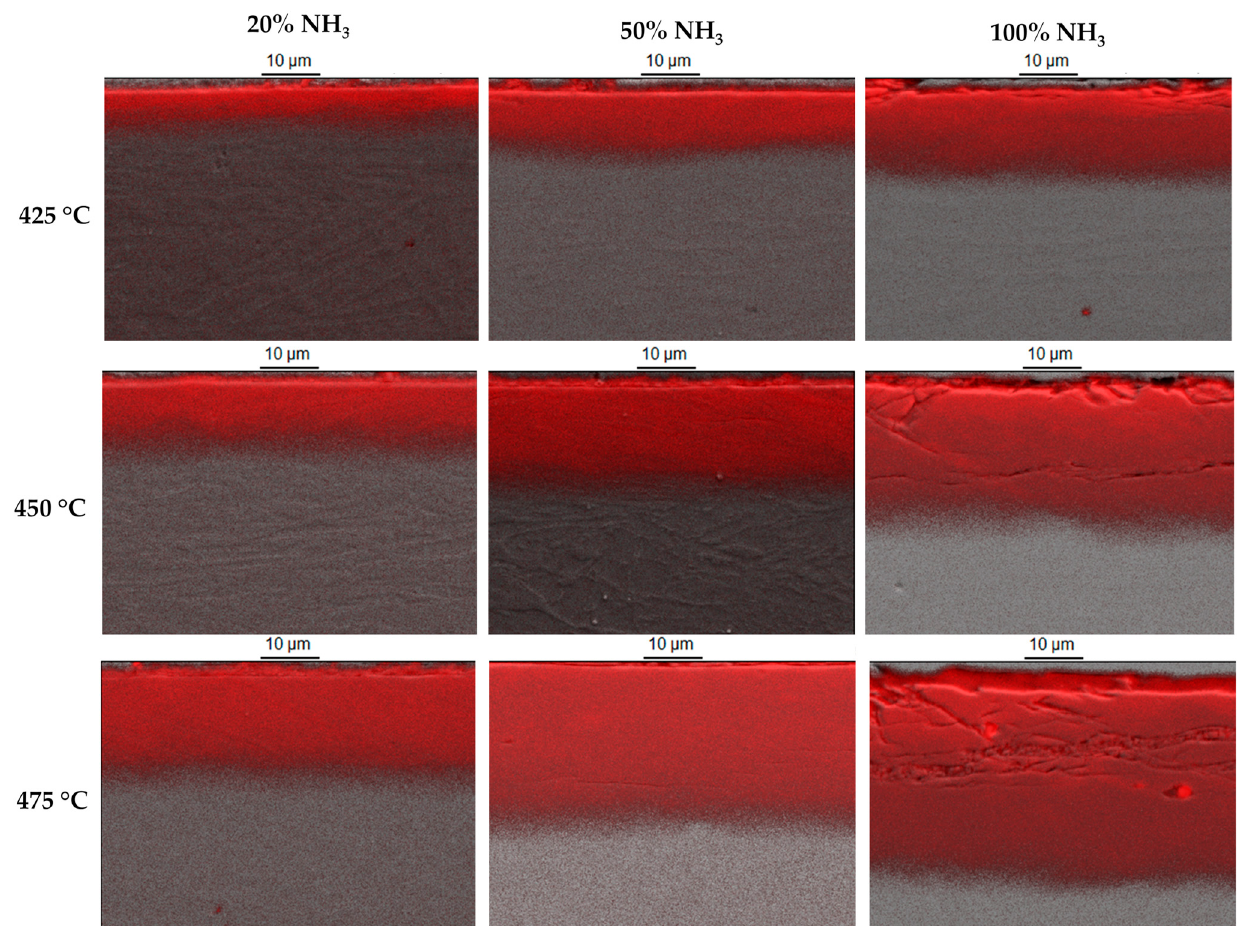
Figure 4. Qualitative distribution of nitrogen (red colour) on cross sections of nitrided layers on Nanoflex steel under condition C with various treatment parameters (treatment time: 4 h). Secondary electron image and WDS X-ray microanalysis.